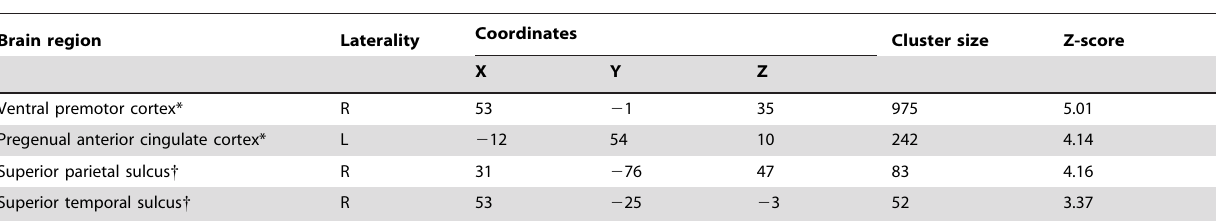
Table 2. Results of t-tests comparing PTSD and control groups.